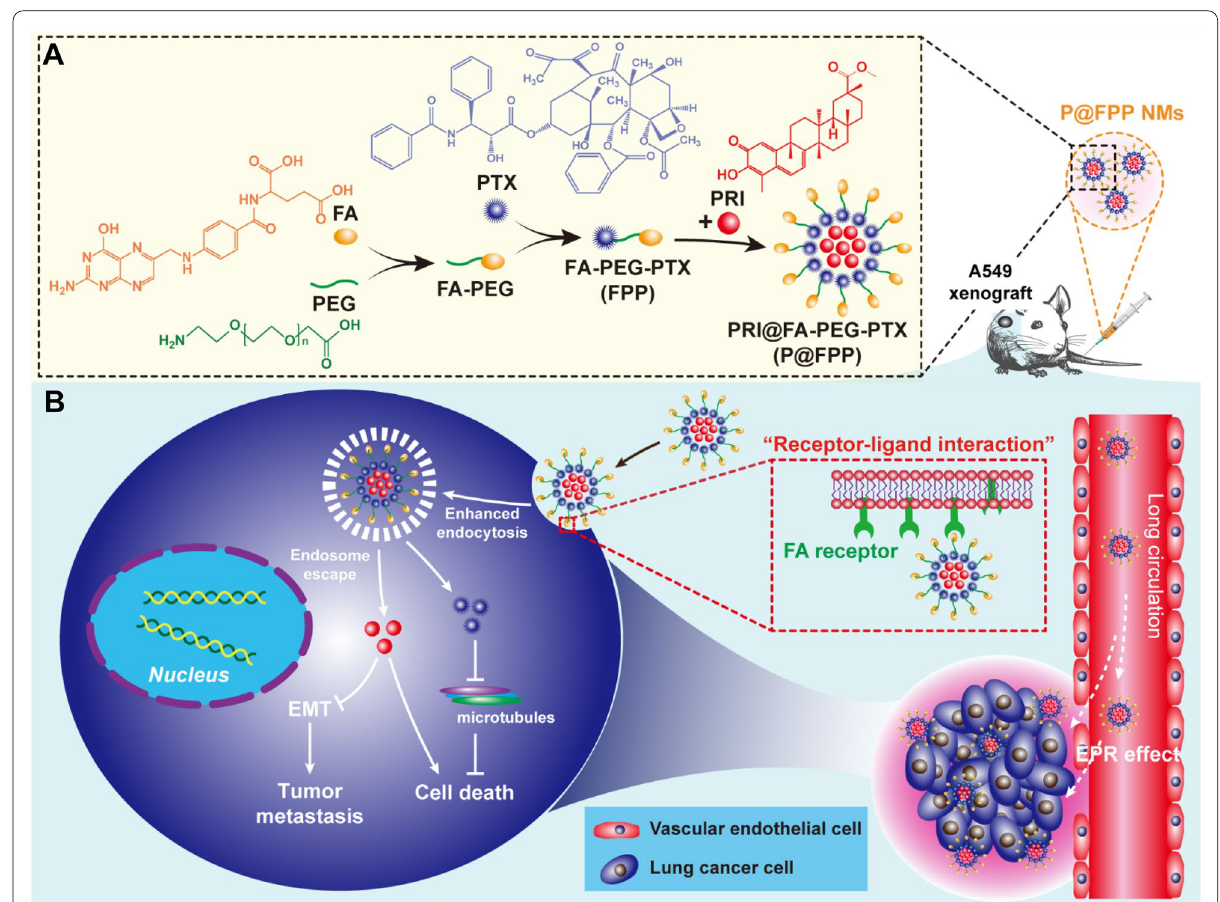
Fig. 1 Design of FA-modified nano-herb micelles for codelivery of PRI and PTX. A Stepwise synthesis illustration of PRI@FA-PEG-PTX (P@FPP) nano-micelles (NMs). B Folic acid (FA) actively targeted NMs co-delivered pristimerin (PRI) and paclitaxel (PTX) for sensitizing chemotherapy of non-small cell lung cancer (NSCLC). P@FPP NMs accumulated in tumor region due to enhanced permeability and retention effect (EPR) and enhanced endocytosis by “receptor-ligand interaction”. PRI and PTX were released from P@FPP NMs after endosomal escape. Subsequently, PRI combined with PTX synergistic inhibited cell viability and metastasis of A549 cells and thus enhanced chemosensitivity of